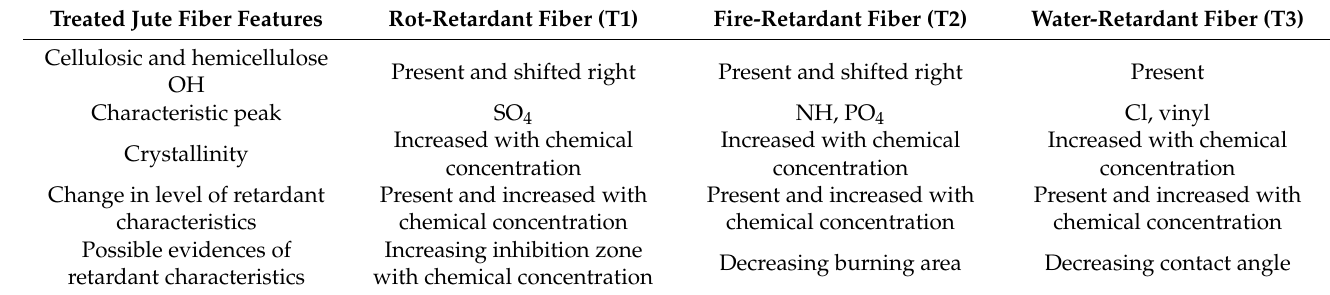
Table 7. Summary of findings from different treatments (T1, T2, and T3) on the jute